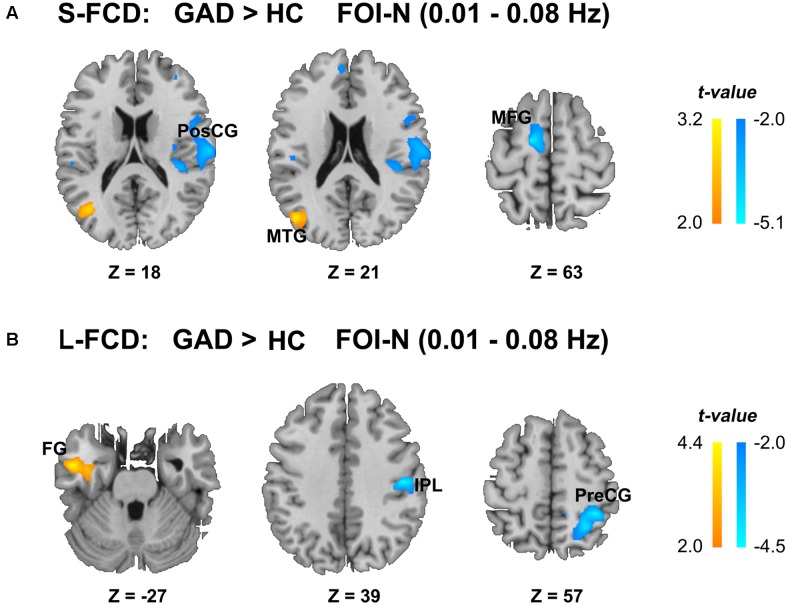
Statistical differences of FCD between two groups in the conventional frequency band FOI-N (0.01–0.08 Hz). (A) Statistical differences of S-FCD between two groups. (B) Statistical differences of L-FCD between two groups. The color bar indicates the t values, which represent increased (warm) and decreased (cool) S-FCD and L-FCD in the GAD patients compared with HCs. Two sample t-test, significant level was set at P < 0.05, with AlphaSim corrected. MTG, middle temporal gyrus; PosCG, postcentral gyrus; MFG, middle frontal gyrus; FG, fusiform gyrus; IPL, inferior parietal lobule; PreCG, precentral gyrus. The left hemisphere is on the left.